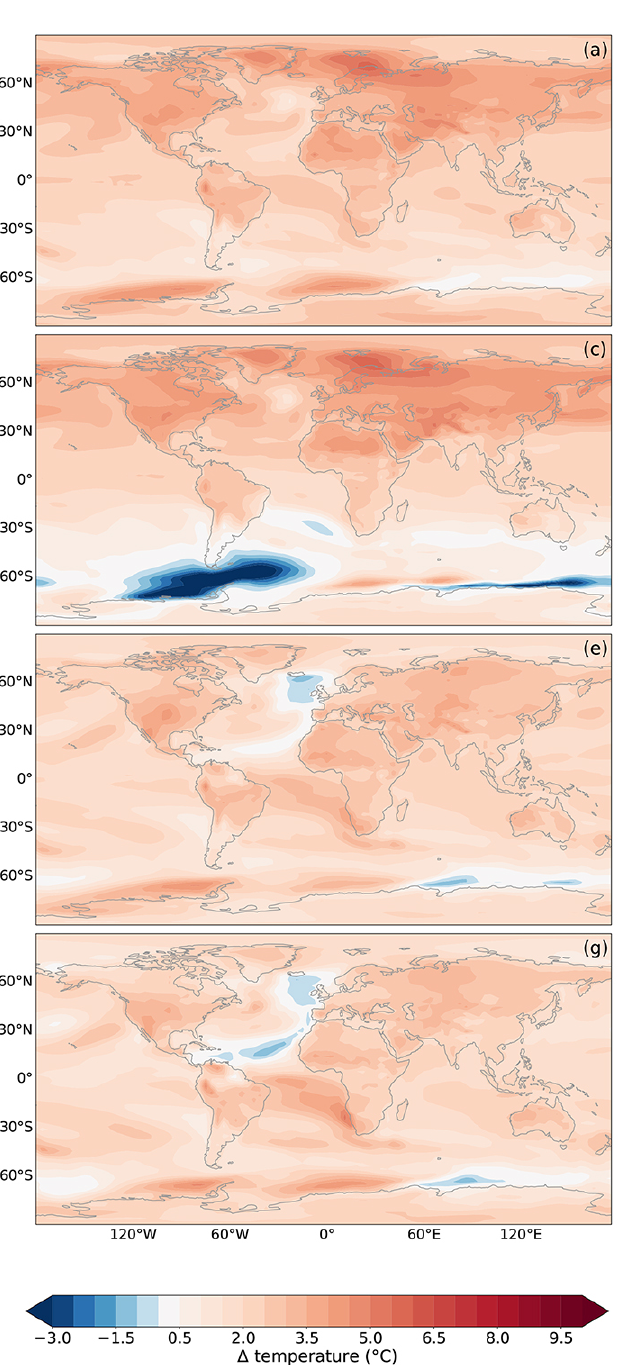
https://doi.org/10.5194/esd-13-1259-2022 Earth Syst. Dynam., 13, 1259–1287,